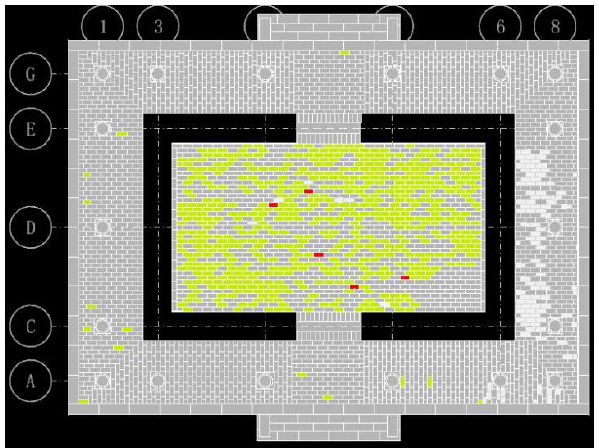
Figure 7. Floor bricks generated with auto-numbering